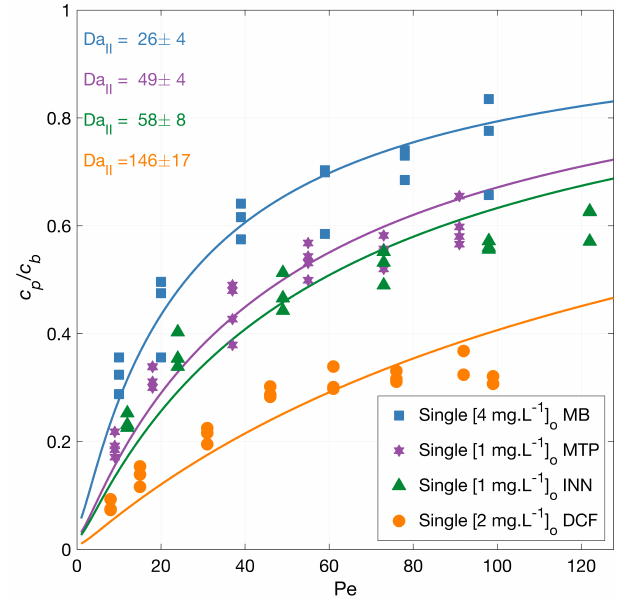
Figure 1. MPs degradation vs. filtration rate. Symbols depict experimental data, and the lines correspond to the mass transport and surface reaction model with indicated fitted Da II